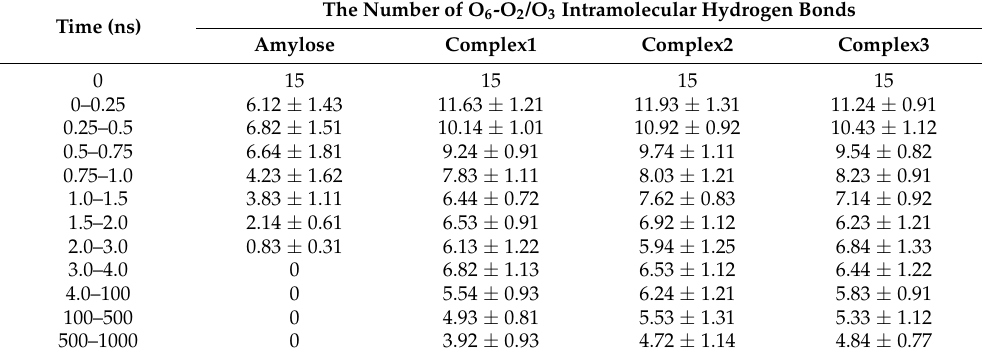
Table 2. The number of O 6 -O 2 /O 3 intramolecular hydrogen bonds of amylose molecule in single- strand system and three amylose–zein complexes with different initial